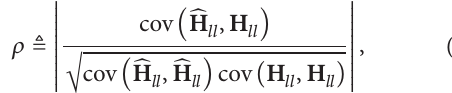
Figure 3: Performance of large-scale fading estimation versus channel condition.